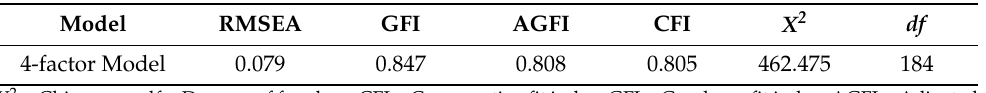
Table 3. 4-factor structure with maximum likelihood estimation.